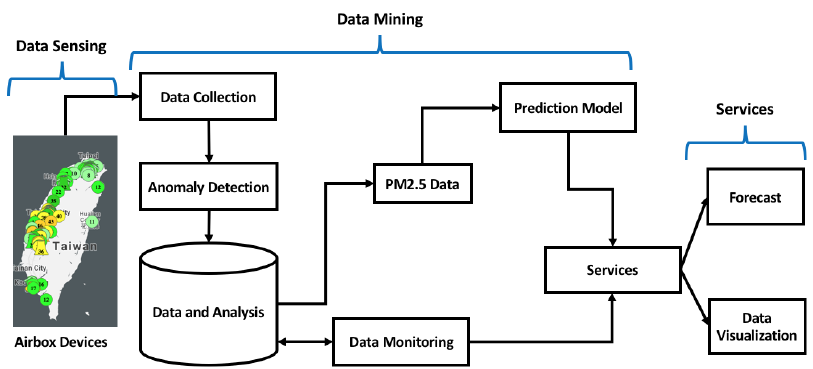
Figure 1. Architecture of the proposed